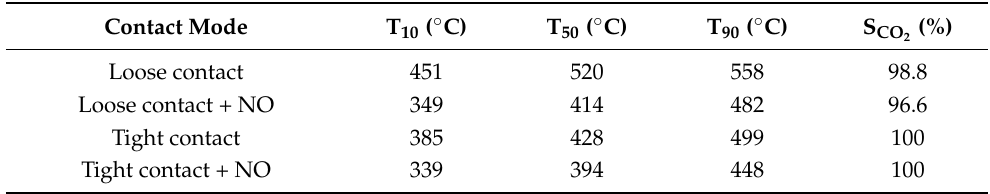
Table 5. Catalytic activity of the CuCo 2 O 4 -N catalysts for soot combustion under the loose and tight contact